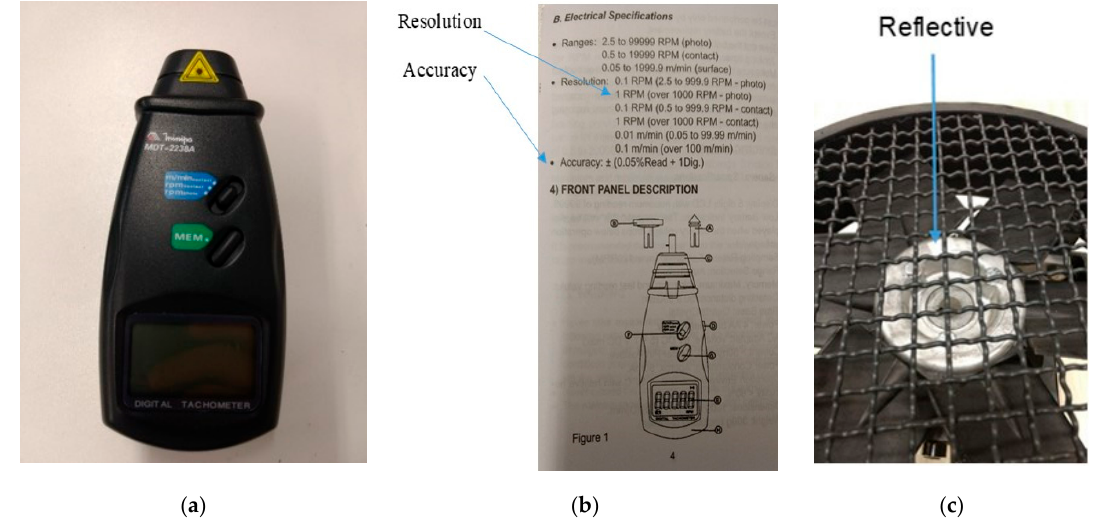
Figure 16. Photo tachometer: ( a ) picture of the photo tachometer used in the setup; ( b ) specifications of the photo tachometer used; and ( c ) Reflective Tape used in the setup.